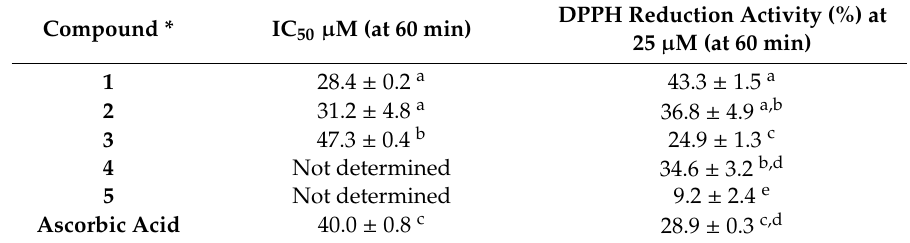
Table 1. DPPH scavenging activity at 25 µ M (mean value and standard deviation) and IC 50 values of the tested compounds and ascorbic acid as positive